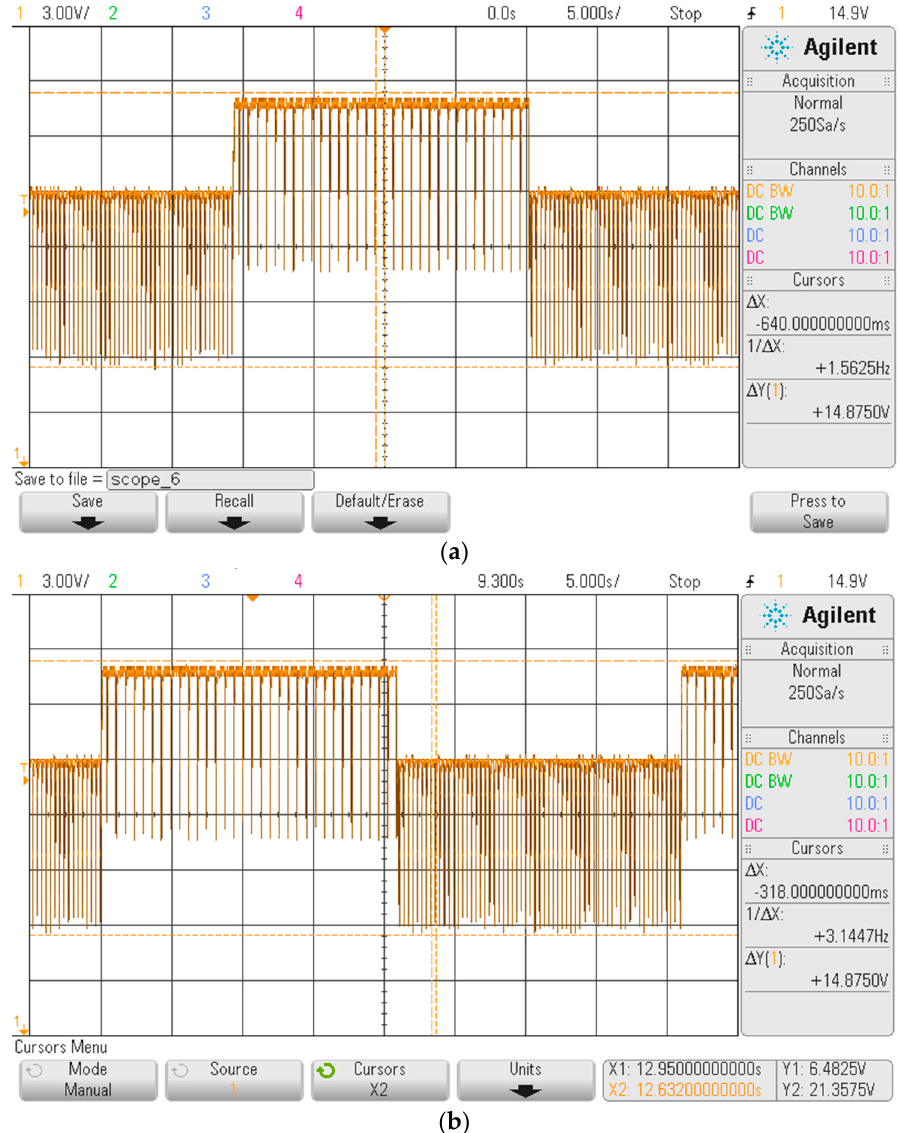
Figure 8 . Screenshot from oscilloscope at the FHRS switch position 0. There are visible switched frequencies 1.56/3.144 of simulated signal every 21 s. The cursors were placed on signal period x and recalculated to frequency as 1/ ∆ x: ( a ) measured f = 1.56 Hz; and ( b ) measured f = 3.144) .